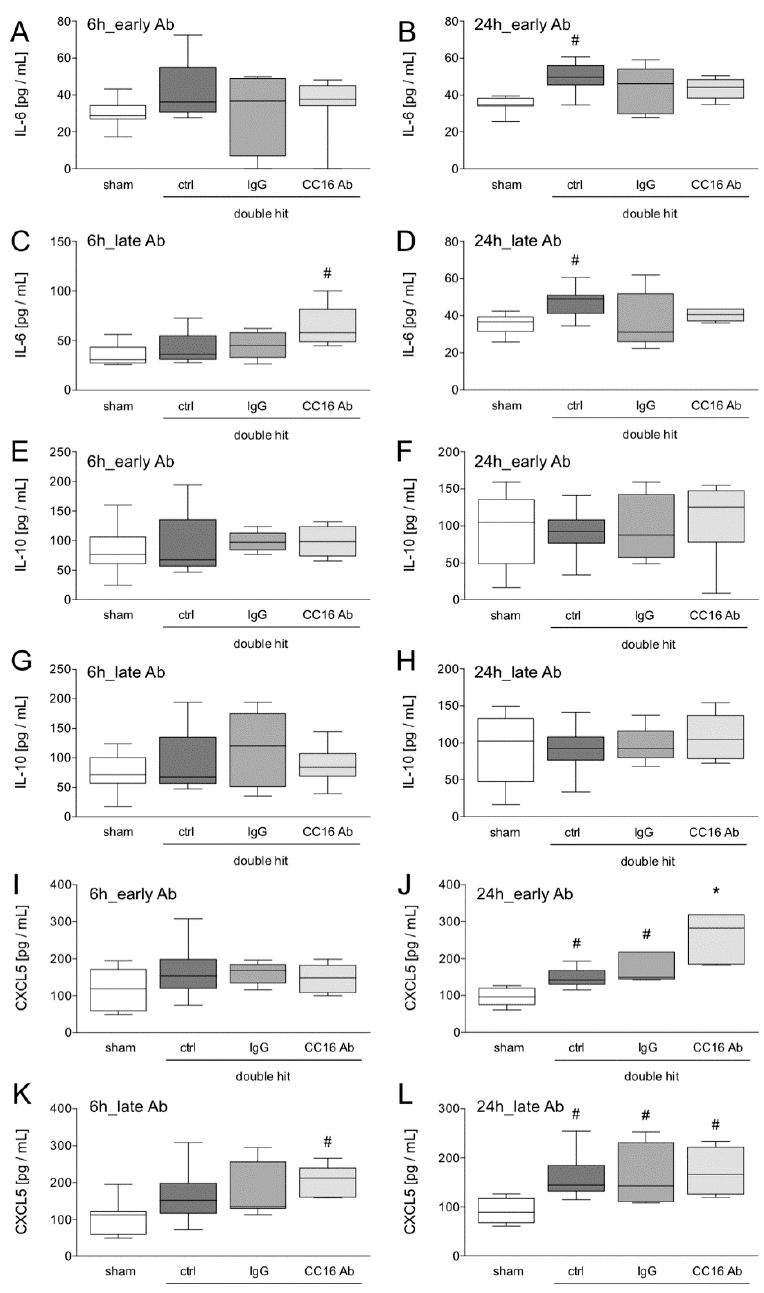
Figure 4. Pulmonary interleukin (IL)-6 ( A – D ), IL-10 ( E – H ) and CXCL5 ( I – L ) levels are shown. Interventions with either CC16 antibody (Ab) or IgG control (IgG) antibody were performed either early (post TxT, A–B, E–F, and I–J) or late (post-CLP, C–D, G–H, and K–L) to the lungs. Six or 24 hours later, the animals were euthanized for sampling. *: p < 0.05 versus all; #: p < 0.05 versus sham, n = 8.